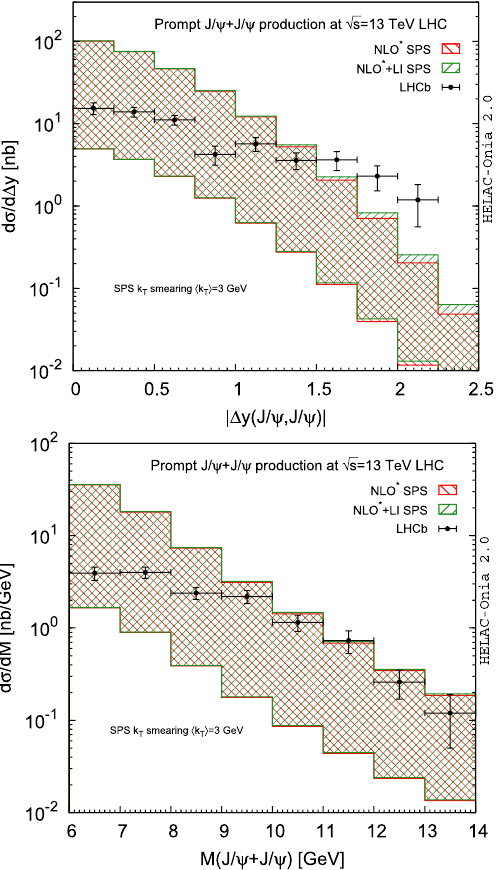
Fig. 3 Rapidity gap | Δ y ( J /ψ, J /ψ) | (left) and invariant mass M ( J /ψ + J /ψ) (right) distributions for di- J /ψ production in CSM √ s = 13 TeV acceptance via SPS within LHCb